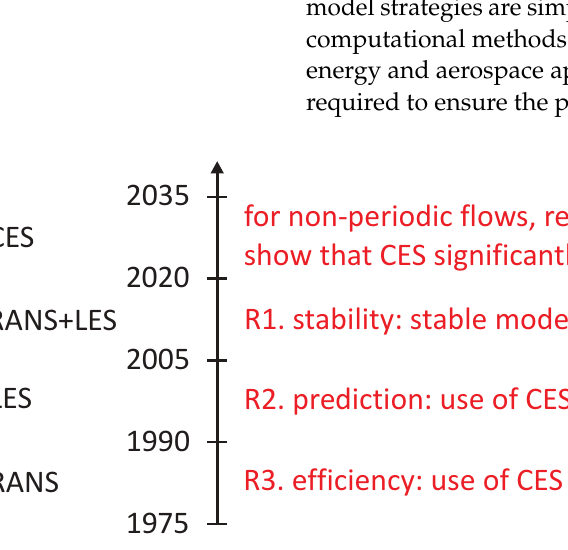
Figure 1. An illustration of the development of computational methods for turbulent flows in time. Here, RANS+LES refers to conventional hybrid RANS-LES methods and CES refers to the CES hybrid RANS-LES methods described here. On the right-hand side (in red), there are requirements for further clarification of advantages of CES methods in relation to previously developed methods (RANS, LES, and RANS+LES).